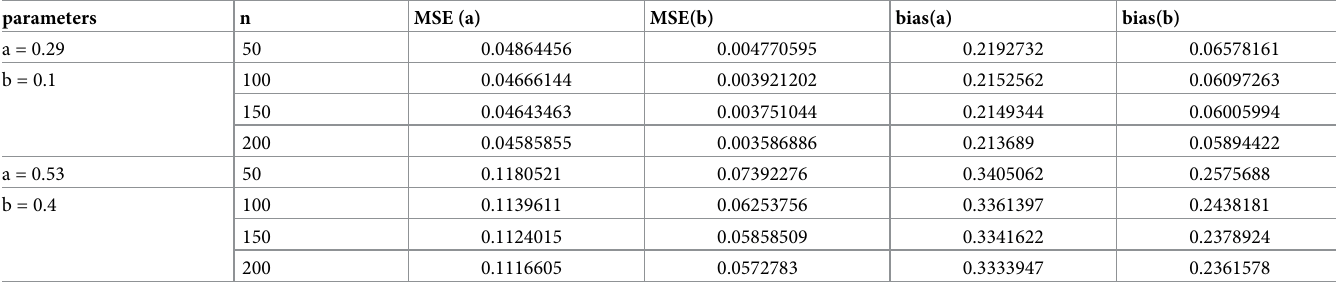
Table 9. Average values of MSE and